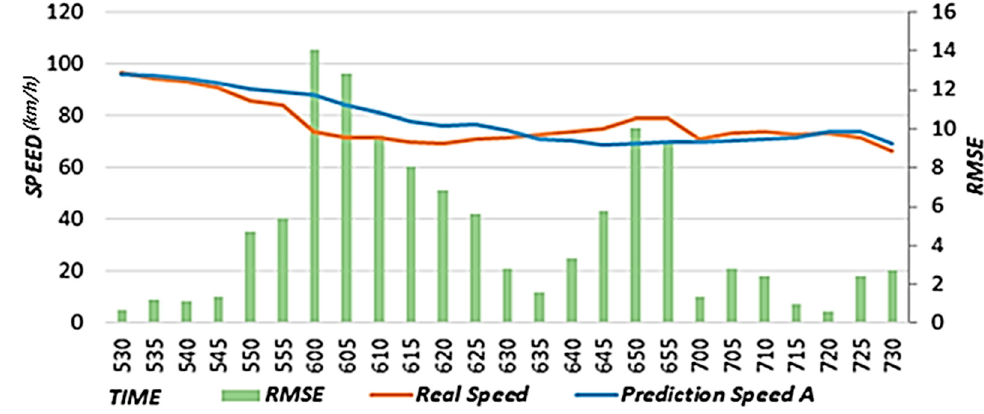
Figure 14. Prediction result considering the historical average speed.